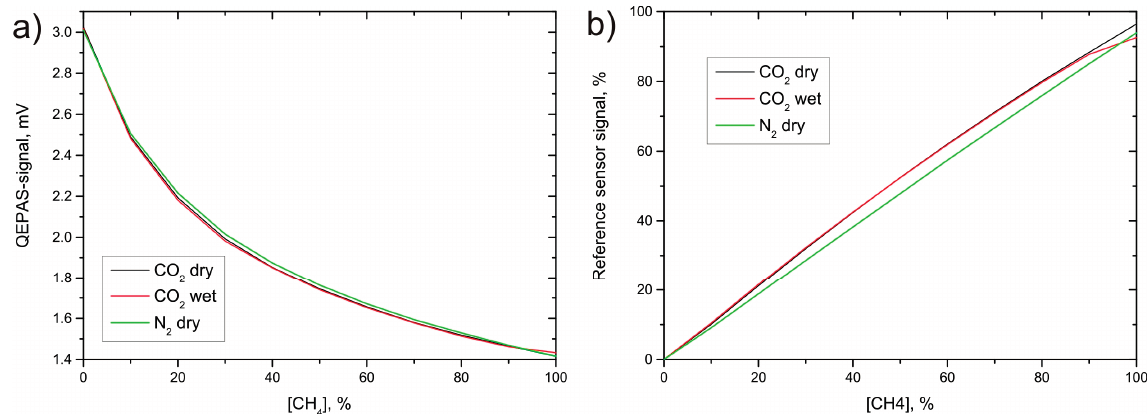
Figure 7. Concentration dependent cross sensitivity measurements for the QEPAS ( a ) and the conventional ( b ) methane sensor; dry nitrogen, dry CO 2 and humidified CO 2 were used as background